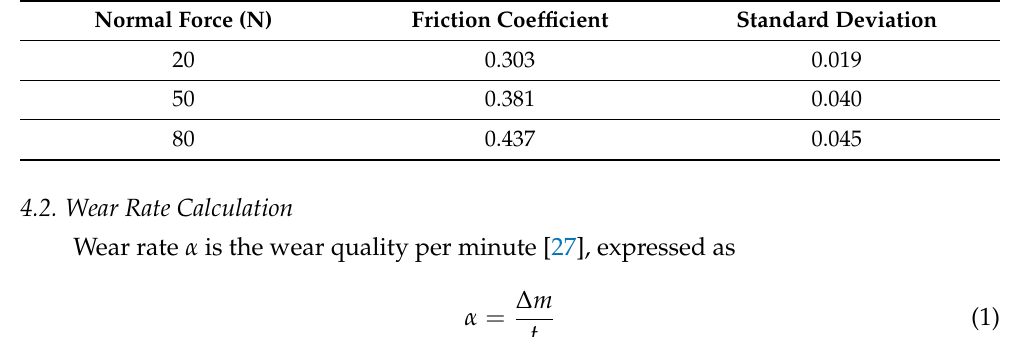
Table 3. Friction coefficient under different normal force values.